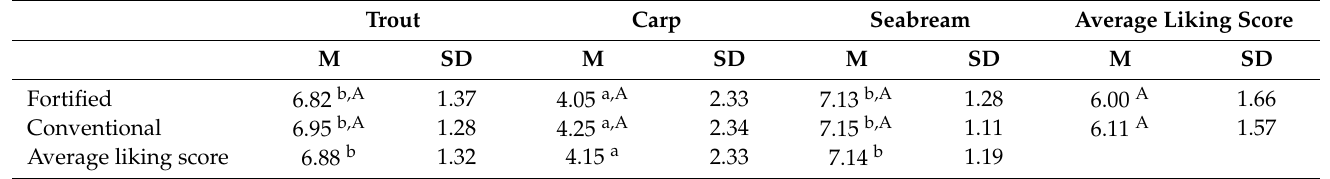
Table 2. Overall liking of fortified and conventional fish according to fish type 1